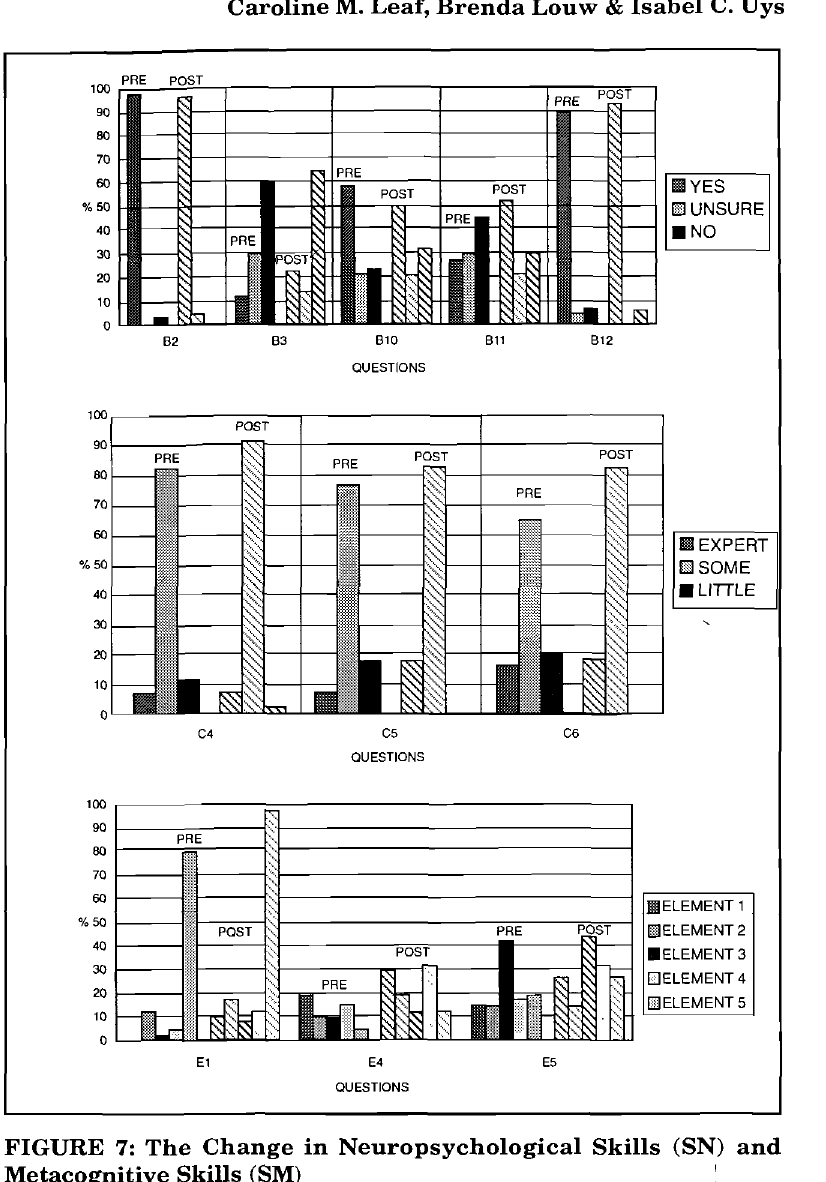
FIGURE 7: The Change in Neuropsychological Skills (SN) and Metacognitive Skills